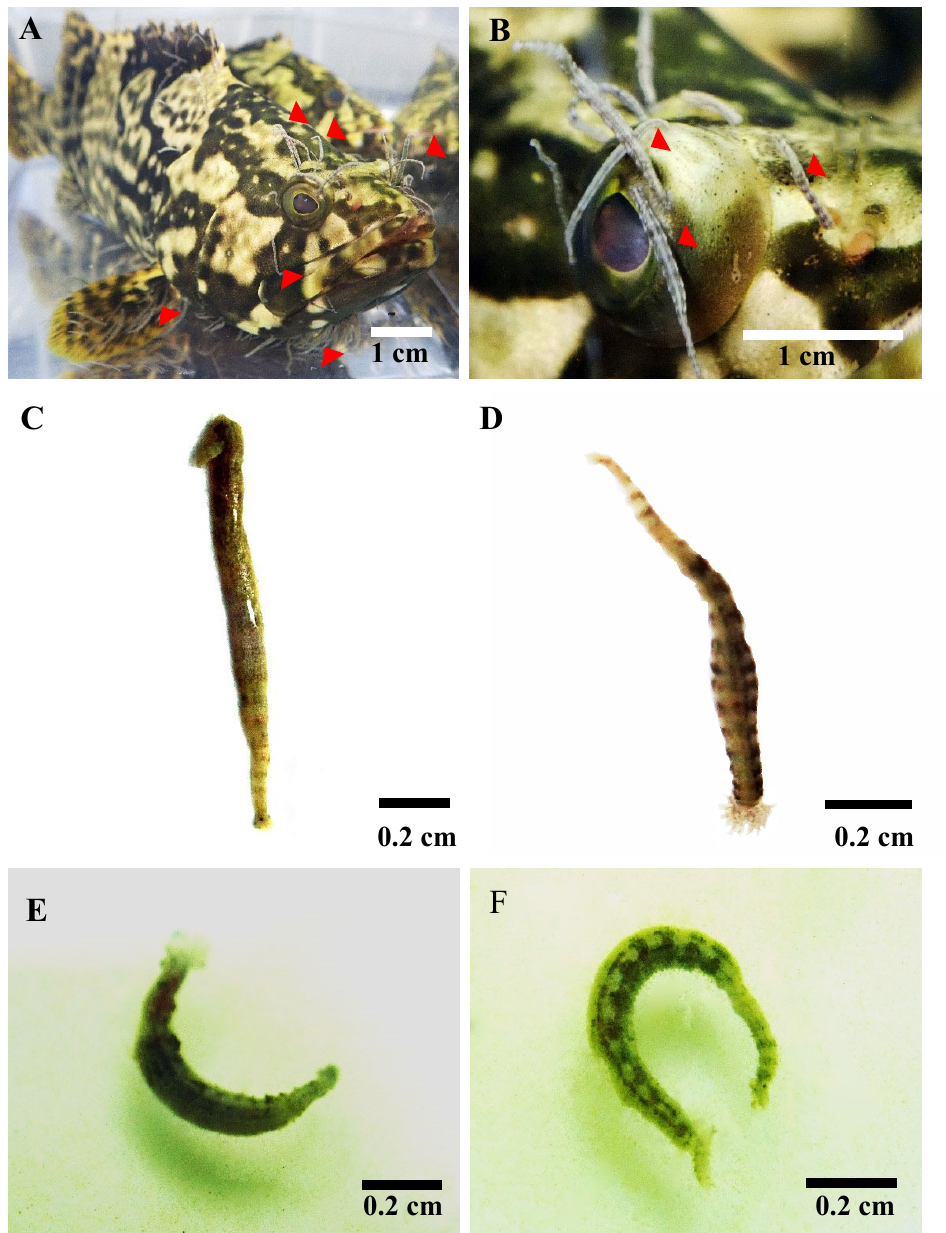
Figure 1. ( A , B ) = Hybrid grouper ( Epinephelus fuscoguttatus × E.lanceolatus ), highly infested with Z. arugamensis, indicated by the arrow (The parasites were isolated and used for the current research), ( C ) = normal parasite (exposed to seawater only, untreated with extract or chemicals, no mortality was noticed), ( D ) = formalin-exposed parasite (exposed to 0.25% of formalin solution in seawater, resulted in mortality of the parasites) ( E , F ) = A. indica aqueous extract-exposed parasites (exposed to low, medium and the higher concentration of plant extract prepared in seawater, resulted in mortality of the parasites with a wrinkled